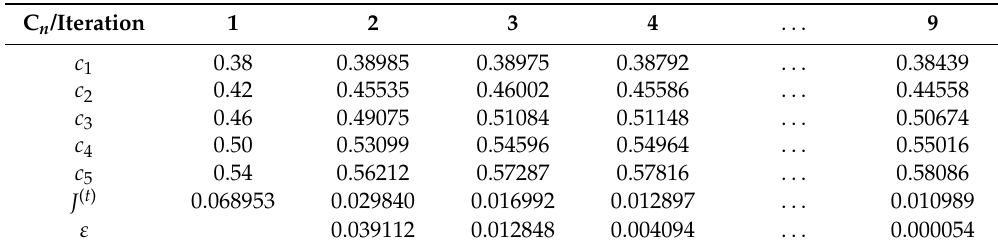
Table 5. Updating the cluster center vector.